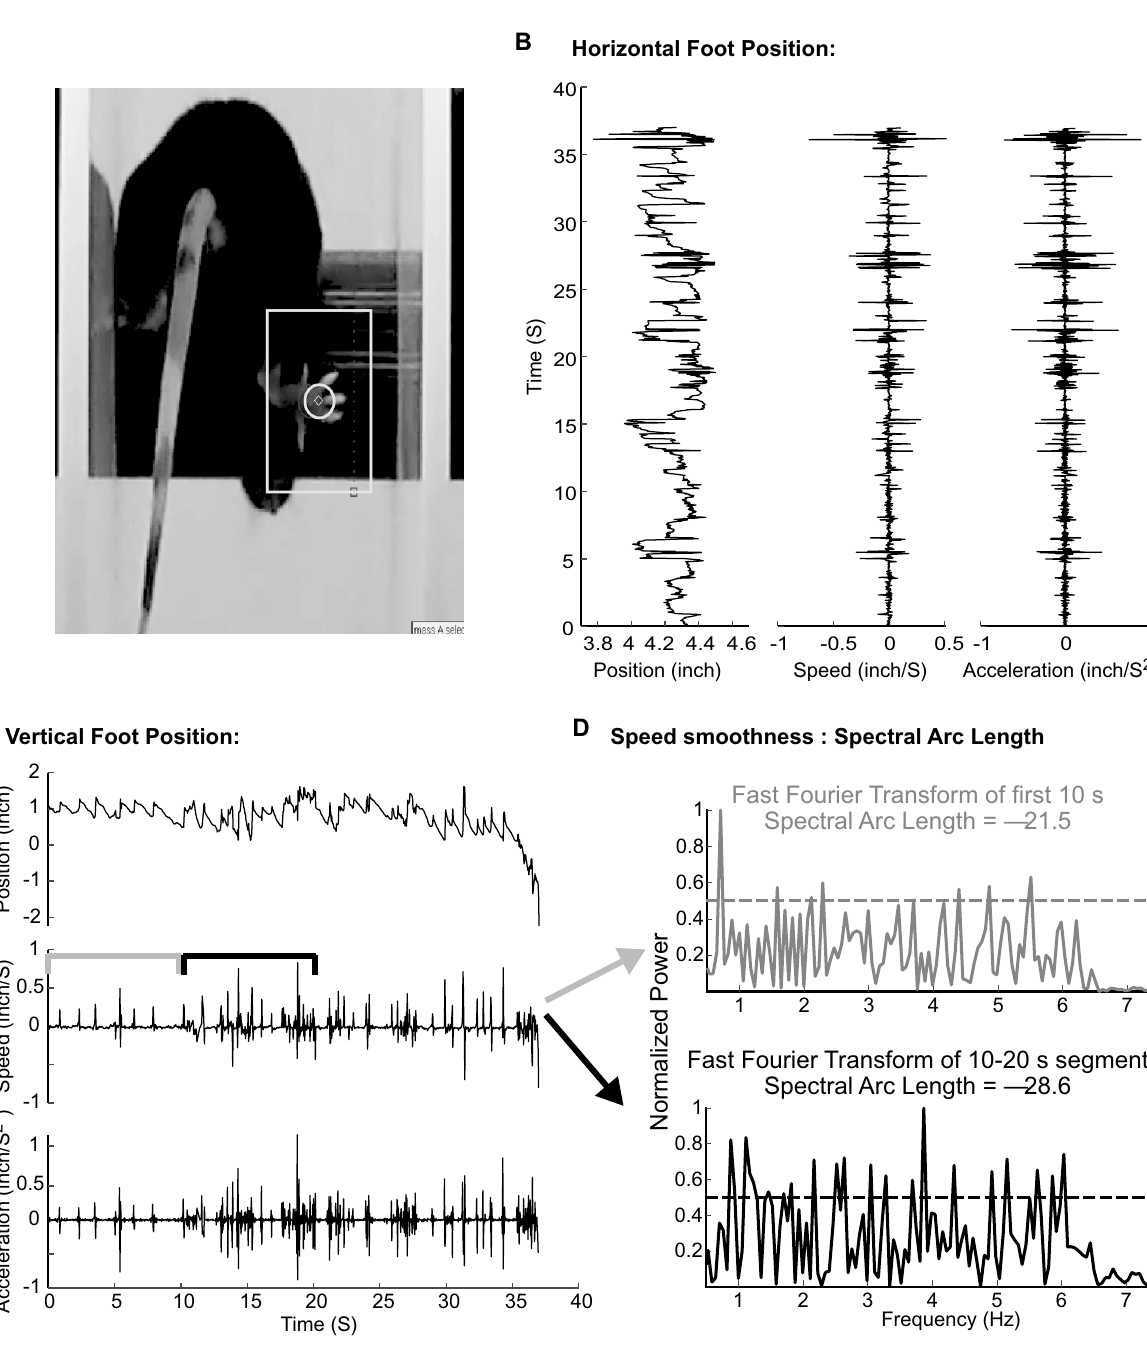
Figure 1. Mouse undergoing a video-rotarod trial. ( A ) Mouse complying with the movement of a rotating rod. A gray colored rectangle outlines the region of interest around the paw (or foot) that the program utilizes to locate serial paw positions. ( B ) Horizontal paw position, speed and acceleration of the right hind limb paw of a mouse over the course of its first rotarod trial. ( C ) Vertical paw position, speed and acceleration of the right hind limb paw of a mouse over the course of its first rotarod trial. Grey and black lines bracket the data analyzed in similarly colored graphs in ( D ). ( D ) Example normalized spectrograms illustrating the computation of spectral arc length to measure movement smoothness. Paw speed earlier in the trial (grey), which undergoes more regular speed deflections, is associated with a normalized spectrogram (grey) with less prominent peaks and thus with a smaller absolute spectral arc length. A less negative, closer to zero, magnitude of this value indicates greater